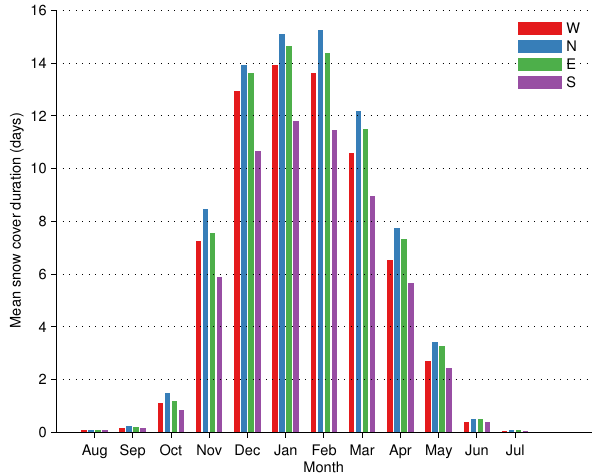
Figure 12. Mean snow cover duration in the Pyrenees over 2000– 2013 for the four main aspect classes (W: west-facing slopes, N: north-facing slopes, E: east-facing slopes, S: south-facing slopes). The snow cover duration was computed only for the area above 800ma.s.l.